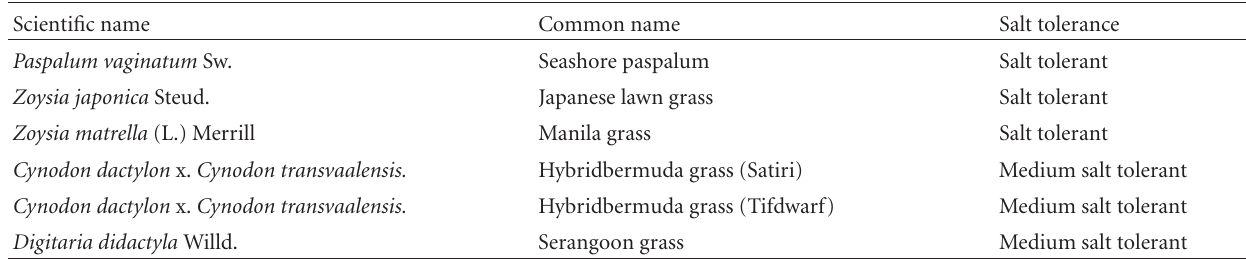
Table 1: Turfgrass species used in this